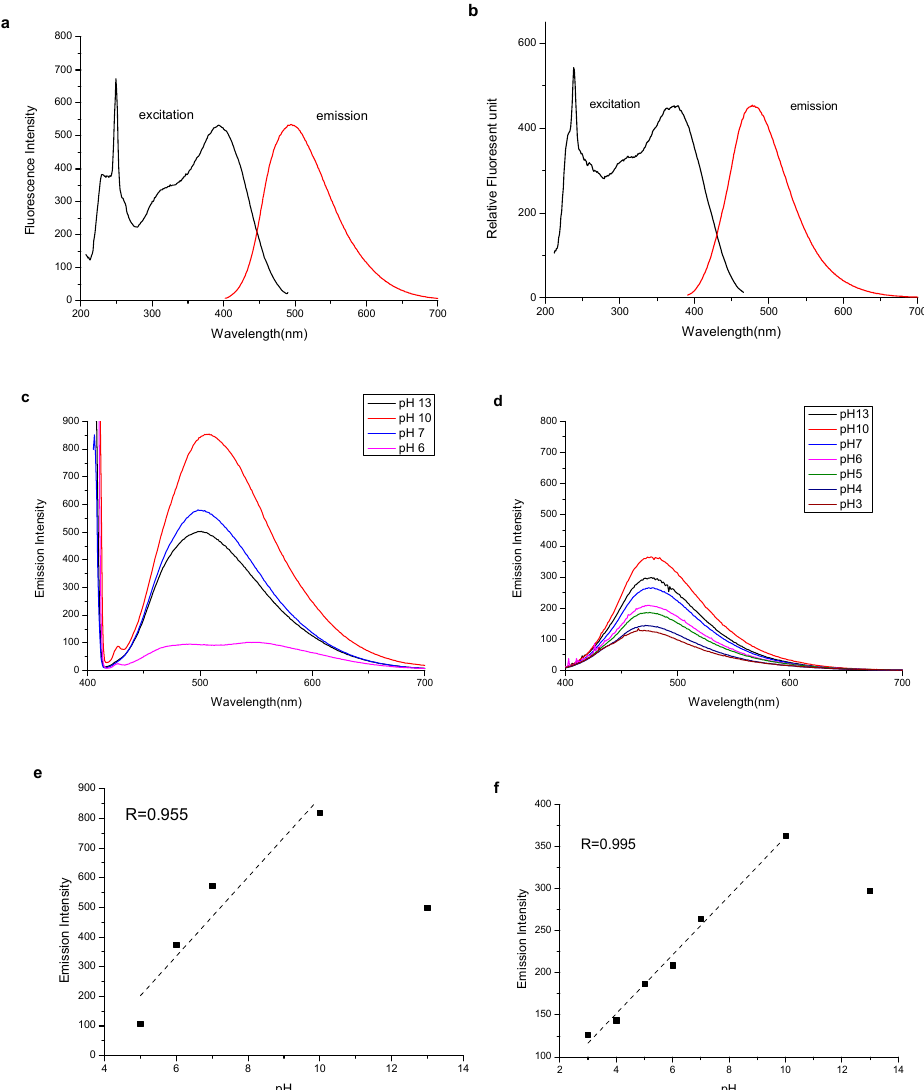
Figure 3. Emission and excitation spectra of ( a ) PDTriG; ( b ) PMEE-PDTriG, measured at pH = 13, 0.01 M. Fluorescence spectra of ( c ) PDTriG; ( d ) PMEE-PDTriG at different pH values at 20 ◦ C, 0.01 mg/mL. Linear fit of fluorescence intensity of ( e ) PDTriG ( f ) PMEE-PDTriG as a function of pH at emission λ max